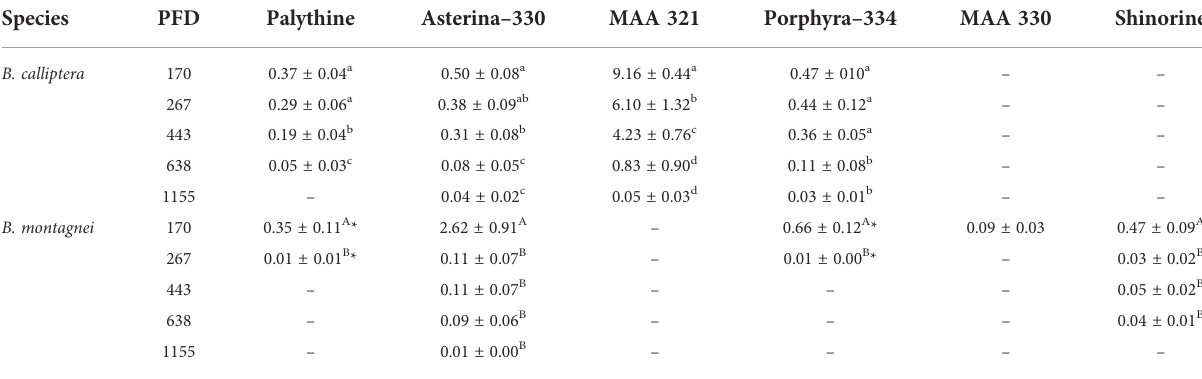
TABLE 2 Mycosporine – like amino acid (MAA) concentrations (mg g – 1 DW) in Bostrychia calliptera and B. montagnei cultured under different photon fl ux densities (PFDs in µmol photons m – 2 s – 1 ) for 14 days.